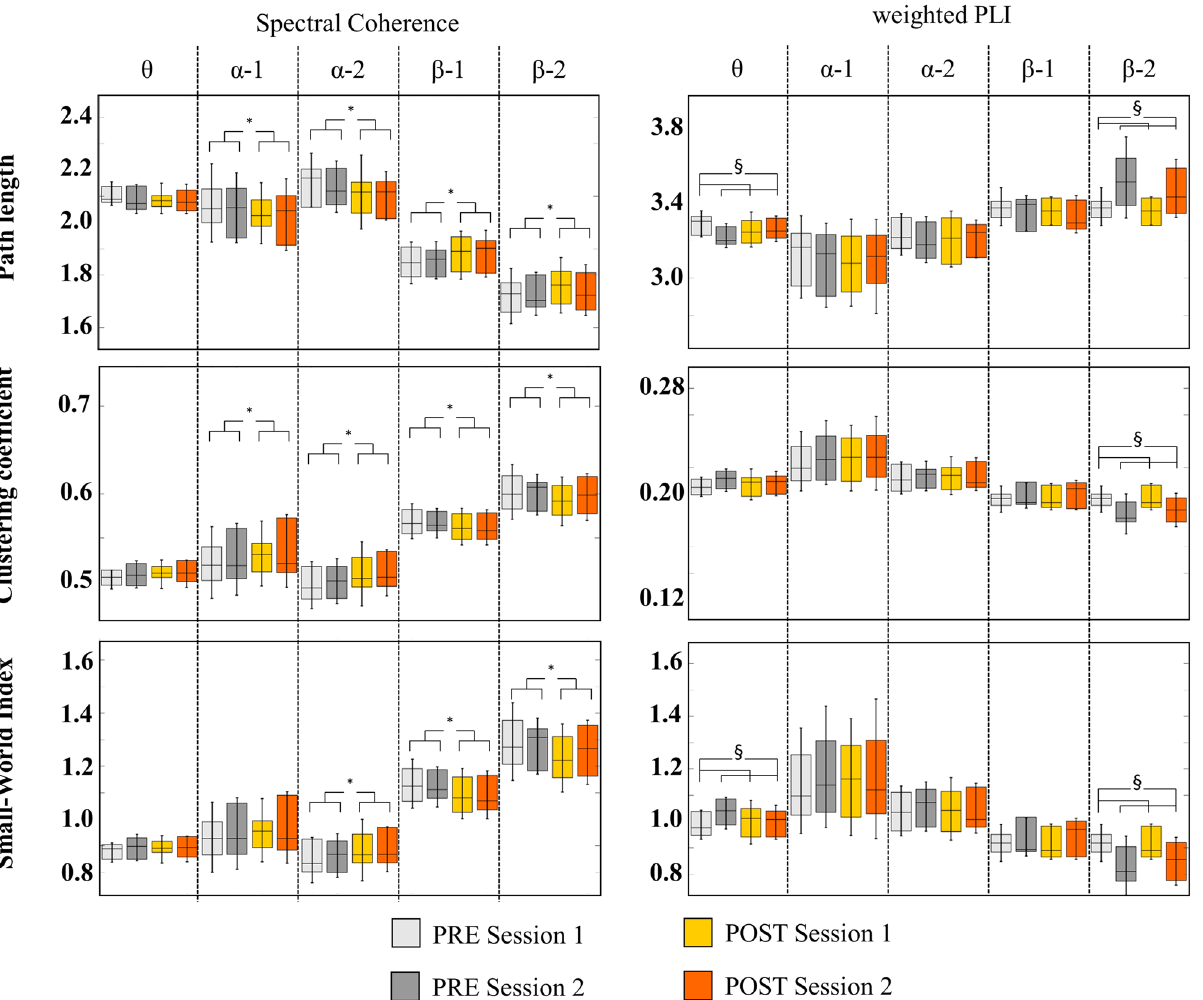
Figure 1. Box plot of graph measures based on Spectral coherence (left column) and weighted PLI (right column) functional connectivity estimation. Measures were obtained from two experimental sessions within 1 week investigating EEG resting states before (PRE) and after (POST) an acute bout of 10 min moderate- intensity running on the treadmill. Boxes display the range of values including group mean and standard deviations for for four conditions: PRE Session I (light grey), PRE Session II (dark grey), POST Session I (yellow) and POST Session II (orange). Graph outcomes analyzed were characteristic path length (upper figure), clustering coefficient (middle figure) and Small-World Index (lower figure). *Significant main effect of exercise (PRE vs. POST) in both sessions (p < 0.05), § significant main effect of session day (Session 1 vs. Session 2) in all pre and post conditions (p <